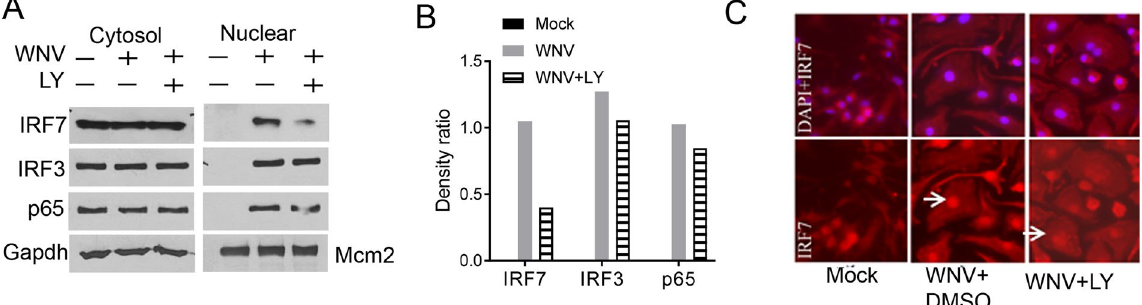
Figure 6. PI3K is critical for WNV-activated nuclear translocation of IRF7. BMDMs were left untreated (mock) or infected with WNV in the presence of vehicle control (DMSO) or 5 μ M of LY294002 (LY) for 24 h. ( A ) Immunoblotting analyses of IRF3, IRF7, and NF- κ Bp65 in the cytoplasmic (Gapdh as the housekeeping protein control) and nuclear fractions (Mcm2 as the housekeeping protein control). Blots shown are cropped from full- length. ( B ) Quantification of the nuclear immunoblot band density in ( A ) by Image J. The results are expressed as the ratio of IRF7/IRF3/p65 to Mcm2. ( C ) Immunofluorescence staining of IRF7 (red) and nuclei by DAPI (blue). Images were acquired with a Zeiss fluorescence microscope. The arrows indicate nuclear IRF7